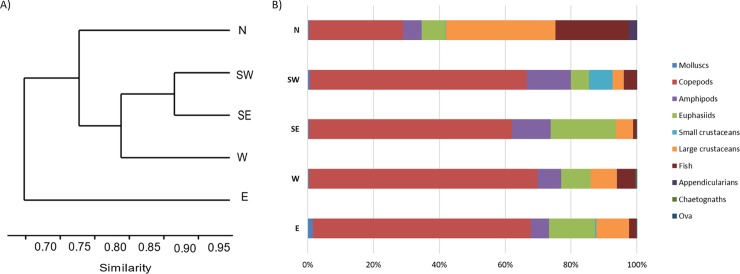
Diet variation between areas.A) Dendrogram for hierarchical clustering of the prey composition of mackerel according to sampling locations (Fig 1) using Bray–Curtis similarities calculated on fourth-root transformed values of the gravimetric weight of prey. B) Composition of mackerel diet by area, based on the gravimetric weight of prey (W%).